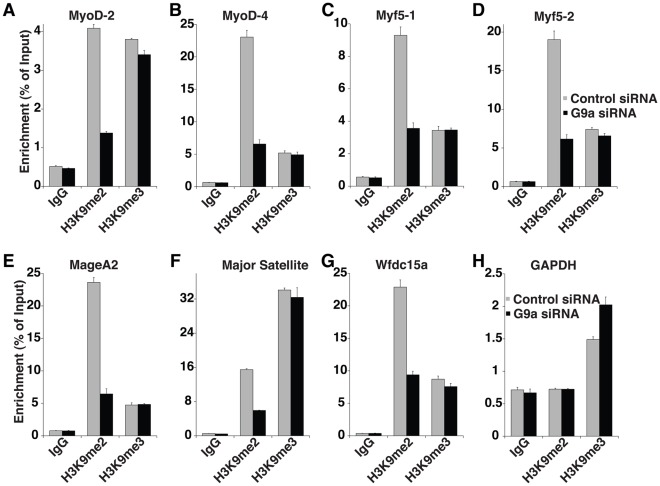
Binding analyses of H3K9 methyl marks in G9a knock-down cells.ChIP-qPCR assays were done using C2C12 cells expressing Flag-Msx1 as well as the control or G9a siRNA using anti-H3K9me2 or anti-H3K9me3 or control IgG, as indicated. ChIP data are expressed as relative enrichment normalized to input in control siRNA cells or G9a knock-down cells.